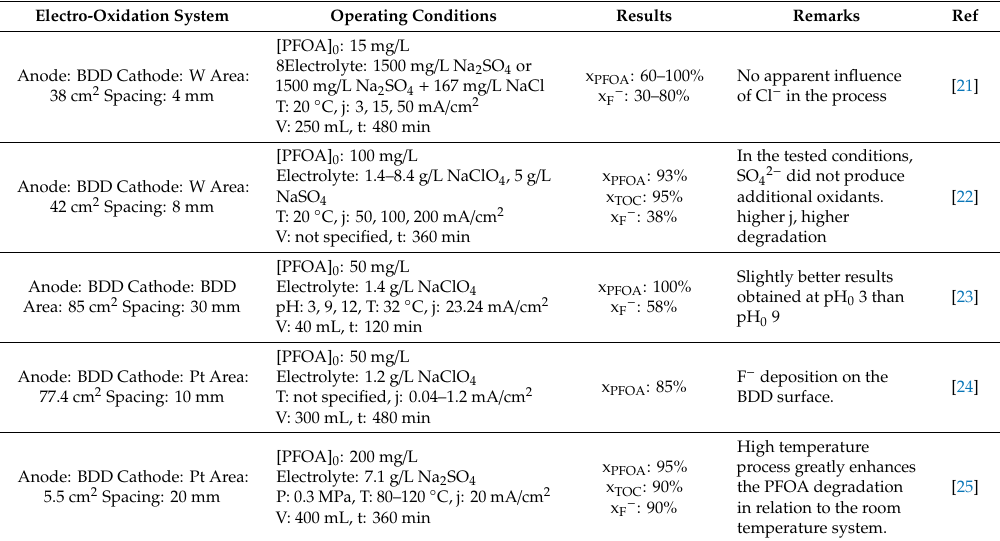
Table 1. Perfluorooctanoic acid (PFOA) electrooxidation with boron-doped diamond (BDD) anode. Electro-Oxidation